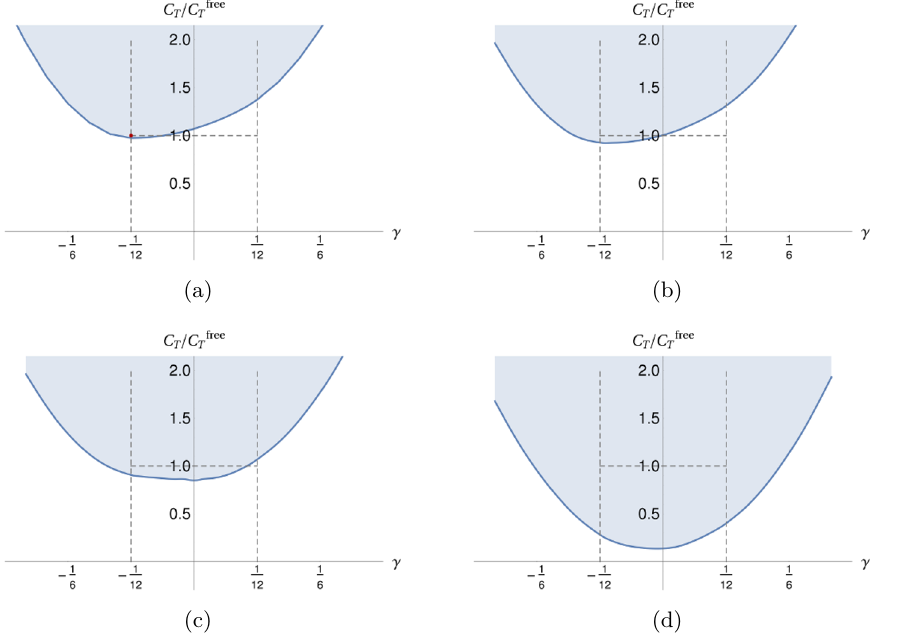
as a function of γ for ∆ φ = 0 . 505 , T free